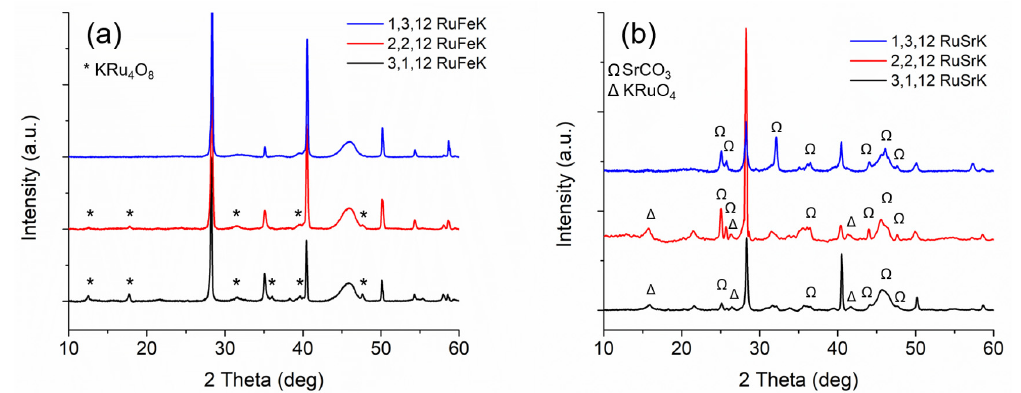
Figure 4. ( a ) XRD patterns of (from top to bottom): 1,3,12 RuFeK, 2,2,12 RuFeK and 3,1,12 RuFeK. ( b ) XRD patterns of (from top to bottom): 1,3,12 RuSrK, 2,2,12 RuSrK, and 3,1,12 RuSrK. Fe containing catalysts contain sharp reflections at 28.33°, 40.5°, 50.1°, and 58.6°, which are